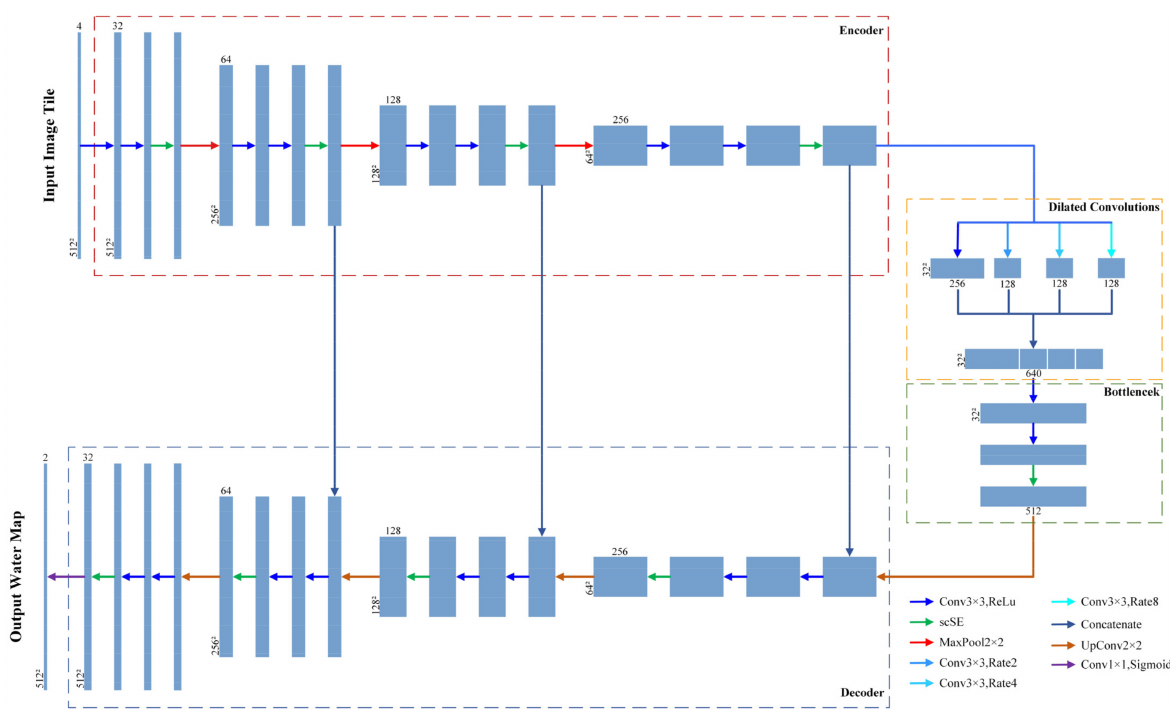
Figure 6. The structure of the Lightweight Multi-Scale Land Surface Water Extraction Network